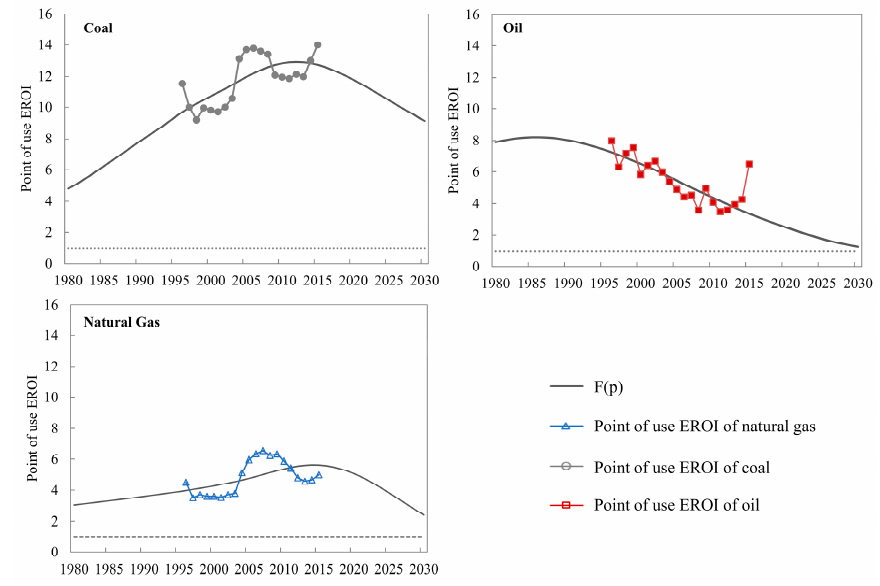
Figure 7. Forecast EROI of Chinese fossil fuels using the dynamic EROI function; the black dotted line is the break ‐ even line, or the point at which the point ‐ of ‐ use EROI is 1:1.